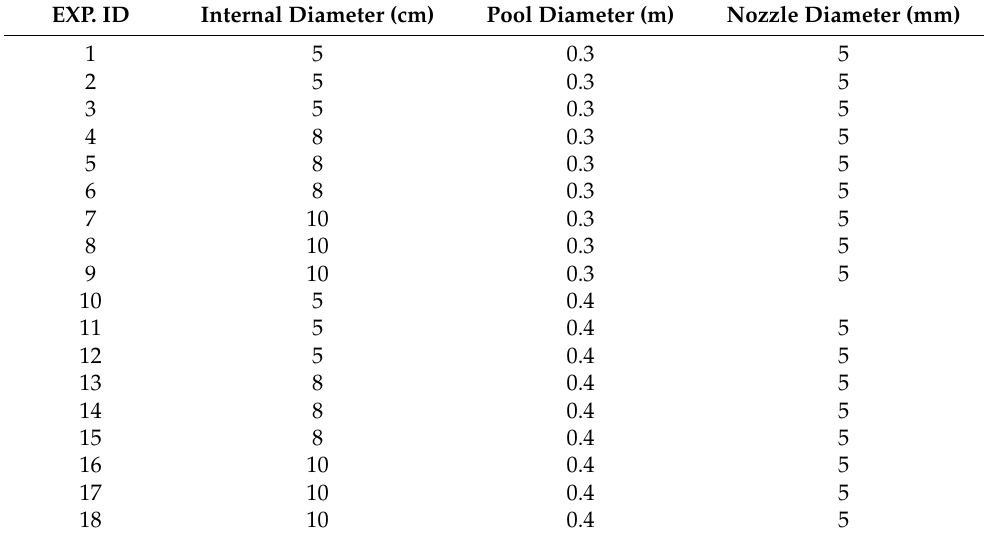
Table 1. Summary of the experimental conditions. EXP.